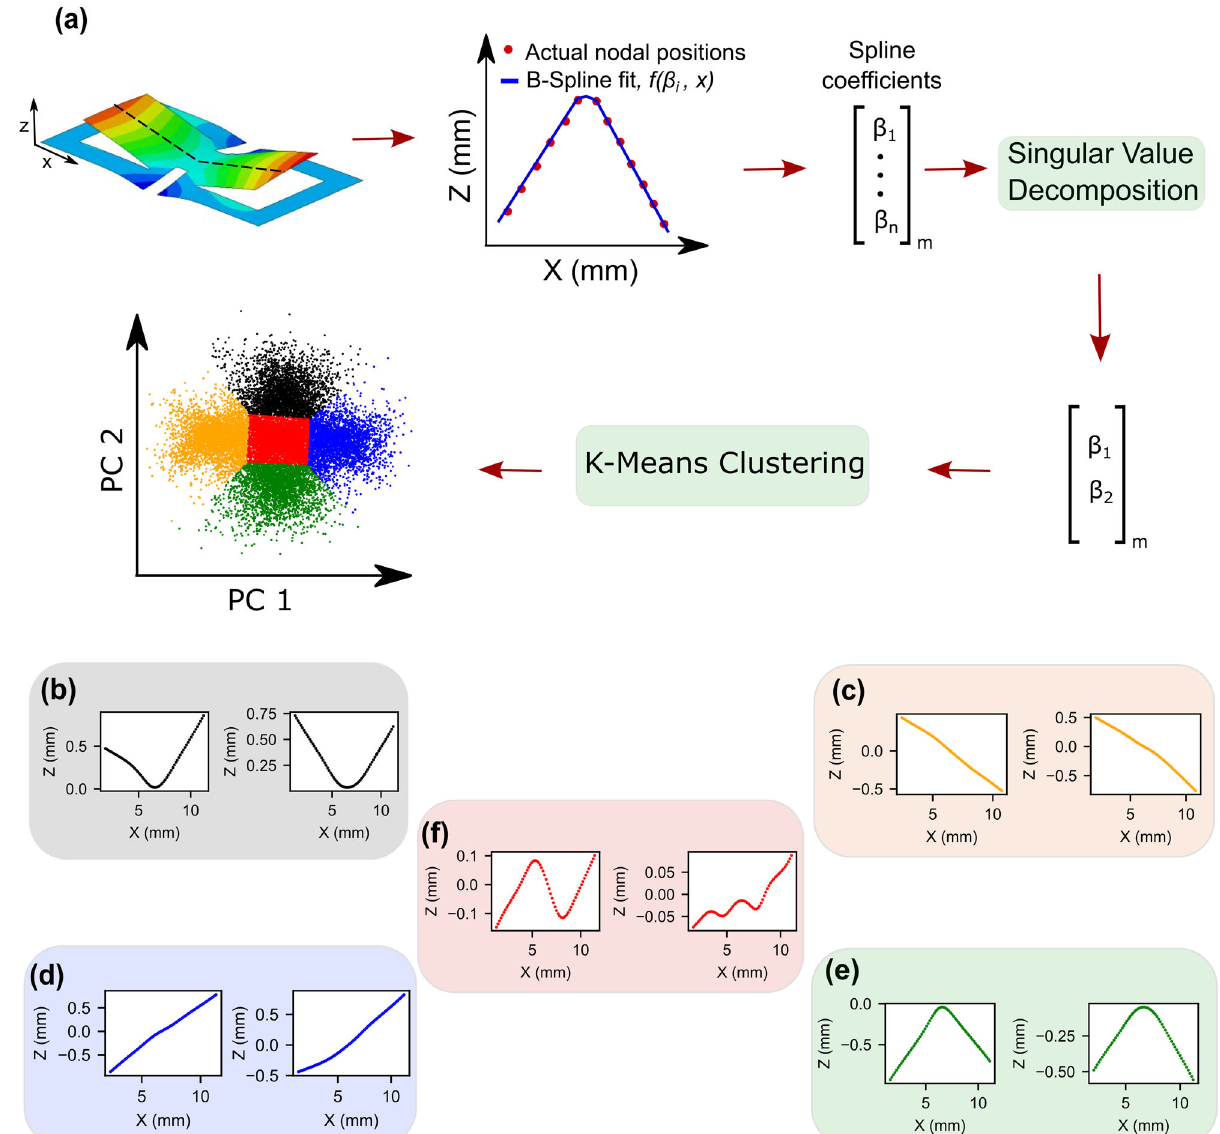
Fig. 3 K-means clustering based on the fi nal z-coordinates of the nodes along the centerline of the Kirigami meta-atom. a Data processing work fl ow for clustering the models based on the deformed shape of the inner panels. Five different clusters were produced by k-Means clustering of the principal components of the B-spline coef fi cients fi tted to the z-coordinates. b – f Representative examples of the fi nal shapes of the centerline of the central panel for the black, yellow, blue, green, and red clusters, respectively shown in the scatter plot in a